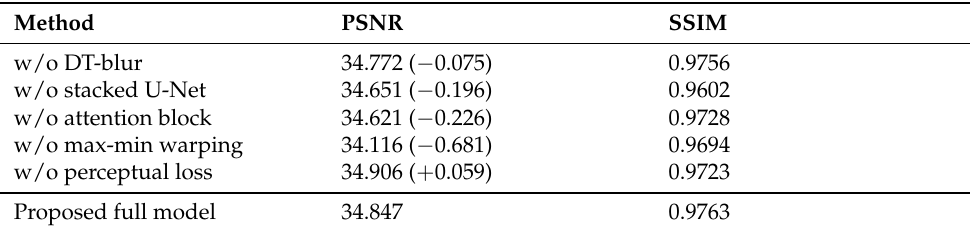
Table 3. Comparison of the contribution of major components of the proposed network in the Vimeo90k